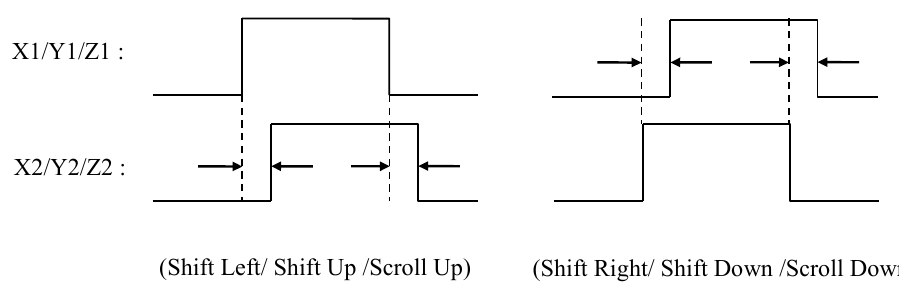
Figure 7. Timing of coordinate pluses corresponding to different mouse movements.